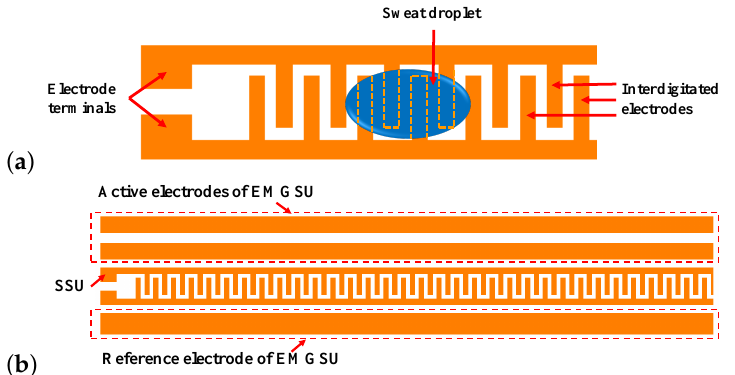
Figure 4. The design and mechanism of the SSU and EMGSU: ( a ) schematic of the design and mechanism of the SSU; and ( b ) illustration of the EMGSU and the